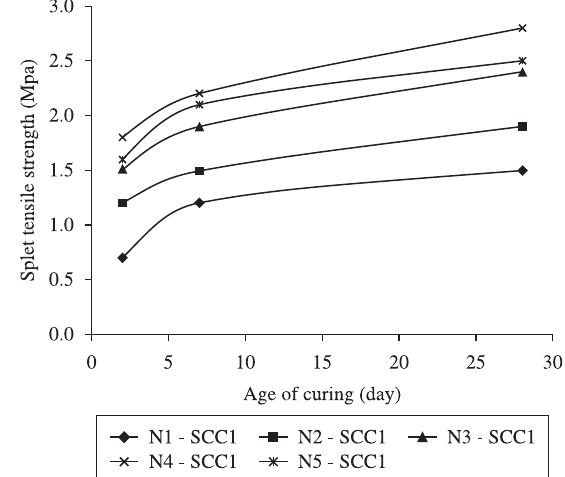
Figure 7. Split tensile strength of N-SCC specimens.